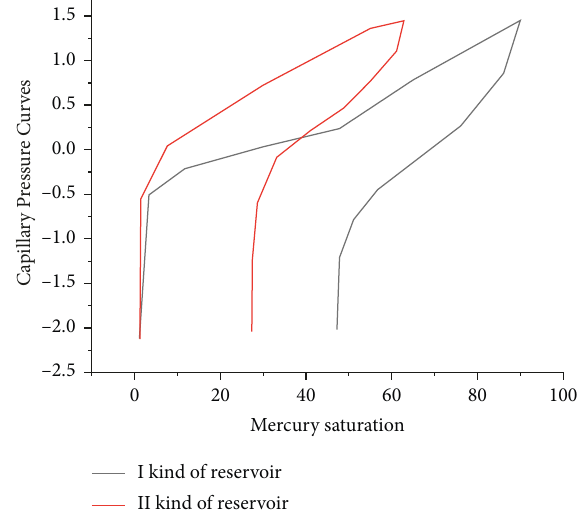
Figure 3: Capillary pressure curve of class I reservoir and class II reservoir.